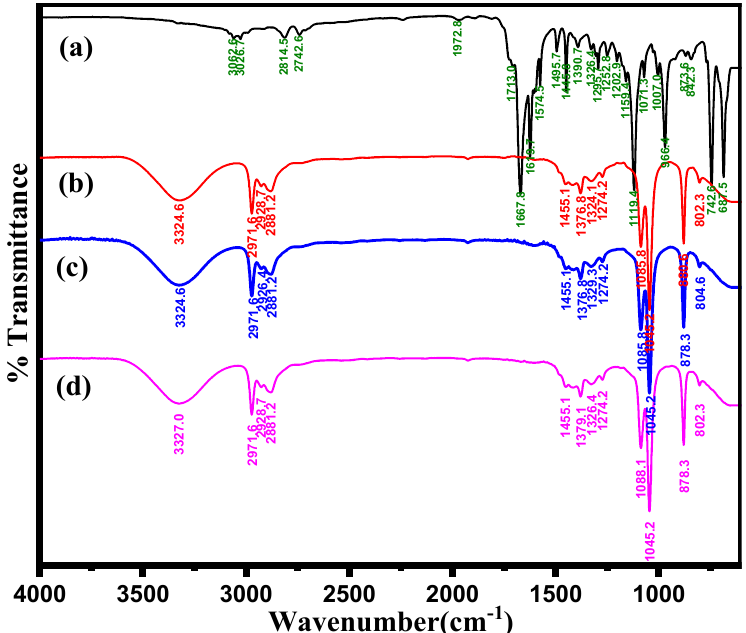
Figure 8. FTIR analysis of CAD + SDS at varying concentrations: ( a ) FTIR analysis of CAD, ( b ) SDS alone in ethanol, ( c ) Pre–micellization SDS + E-OH + CAD ( d ) Post-micellization SDS + E-OH + CAD .